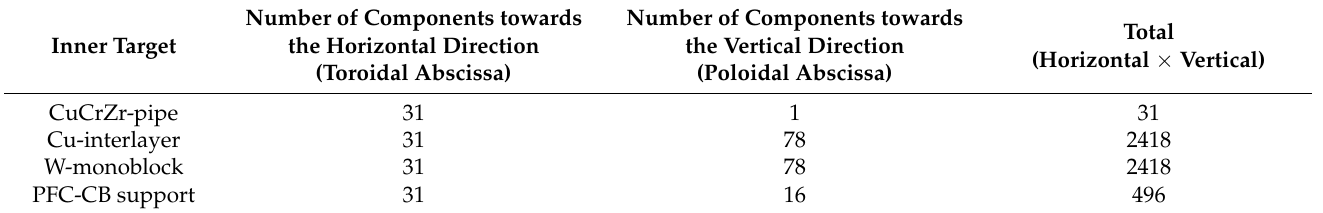
Figure 9. Single units of CuCrZr pipe (inboard and outboard) with W-monoblocks, Cu-interlayers and PFC-CB supports. Table 2. Number of PFCs elements towards the horizontal and vertical direction of the inner target (see Figure 7).